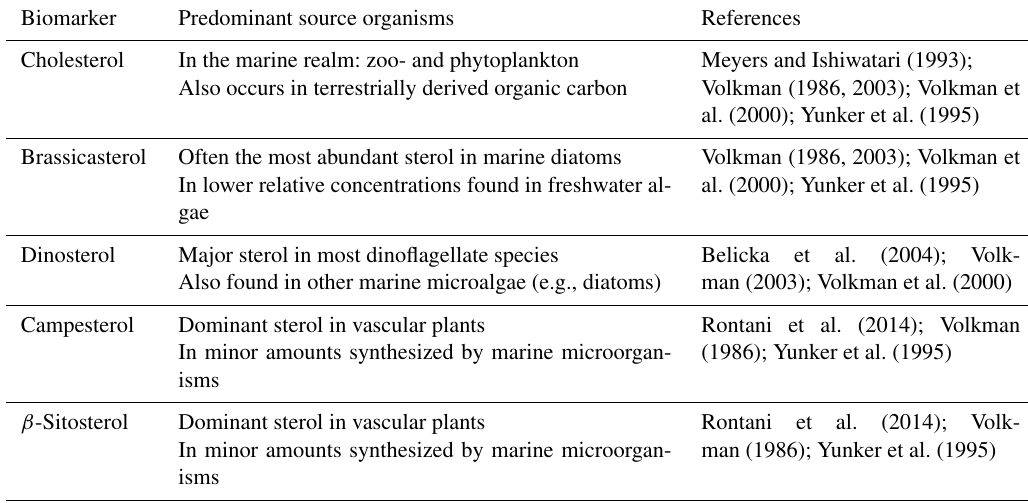
Table 2. Overview of the dominant sources of different sterol biomarkers measured in this study. Biomarker Predominant source